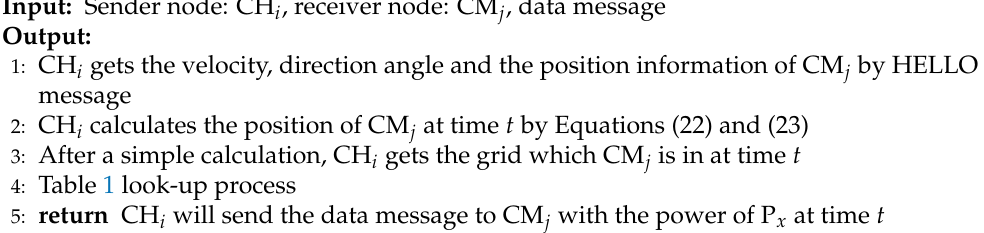
Algorithm 3 Dynamic Transmission Power of Cluster Heads Algorithm